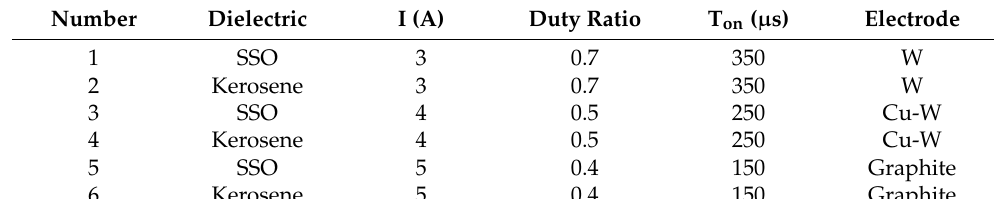
13 of 20 Figure 7. Processing performance comparison of electrodes in SSO and kerosene; ( a ) MRR compar- ison of electrodes in SSO and kerosene; ( b ) EEV comparison of electrodes in SSO and kerosene; ( c ) Ra comparison of electrodes in SSO and kerosene; ( d ) Comparison of electrode EEC in SSO and kerosene. 3.3. Analysis of the Effect of Dielectrics on Debris Size EDM will continuously generate granular debris in the discharge gap. If the debris